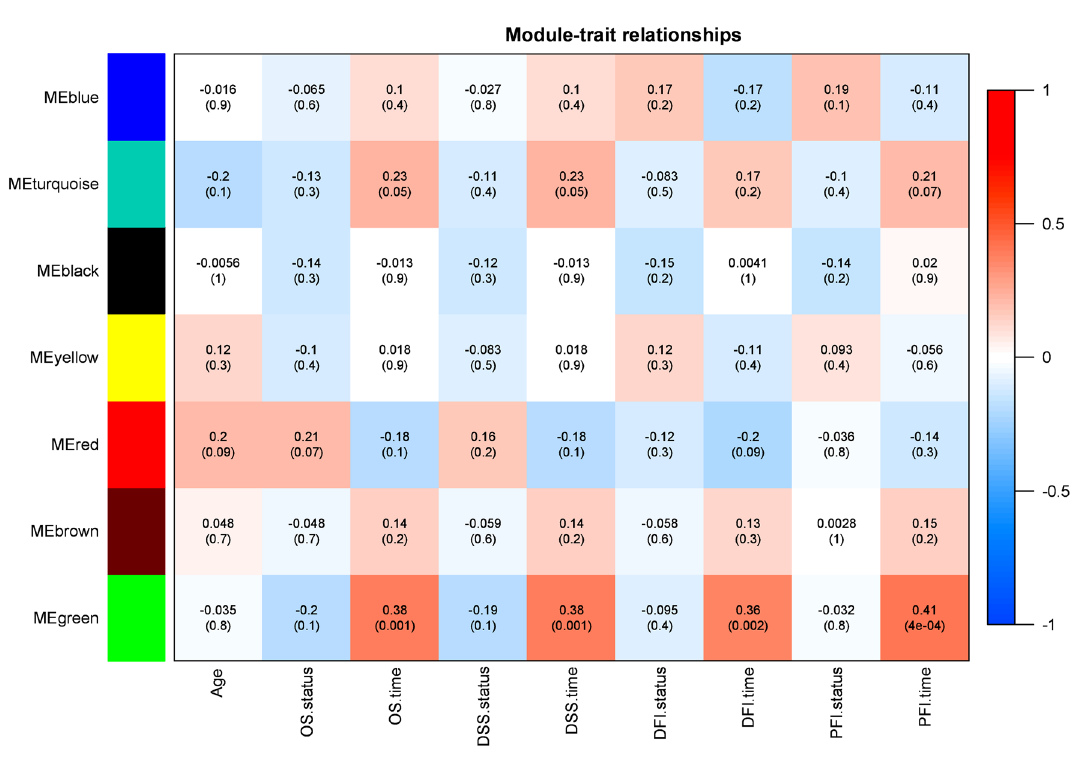
Figure 3. Median rank and Z-summary statistics in the module preservation process. ( a ) The plot shows the module position in the test dataset based on the Median rank. ( b ) The plot illustrates the analysis of the Z-summary between different modules in the test dataset.